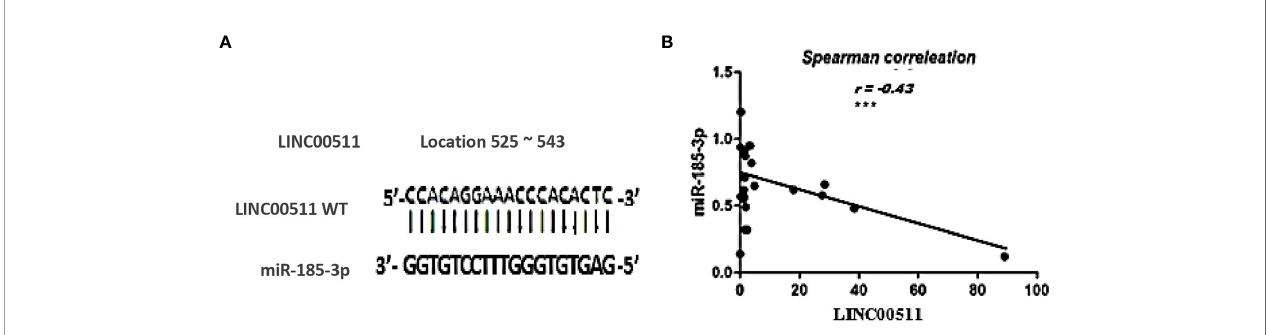
FIGURE 3 | The relationship between LINC00511 and miR-185-3p in BC patients ( n = 70). (A) the predicted potential binding regions between LINC00511 WT (top) and miR-185-3p (bottom). (B) Spearman correlation analysis of LINC00511 and miR-185-3p. *** p < 0.001 [WT, wild